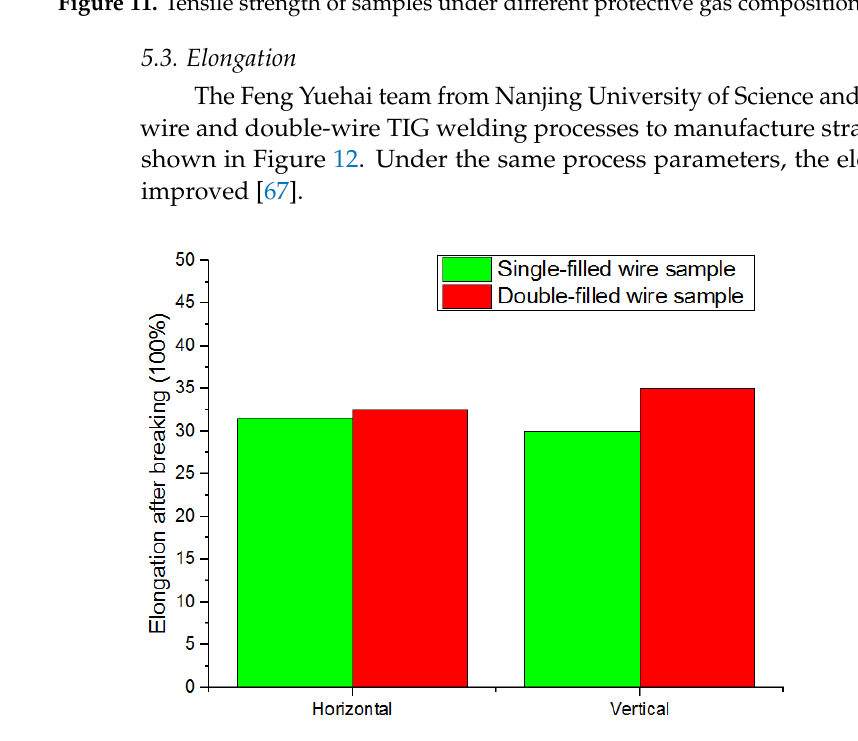
Figure 12. Elongation of single-filled wire and double-filled wire samples.